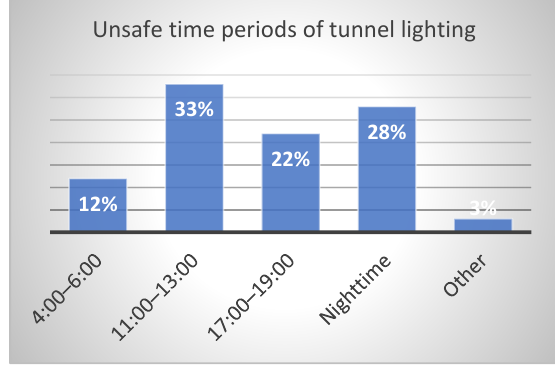
Figure 4. Unsafe time periods of tunnel lighting.